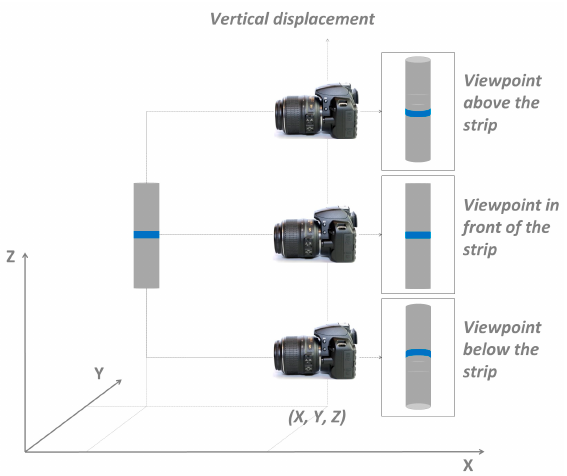
Figure 1. Image acquisition using camera displacement in a line path parallel to the cylindrical axis.